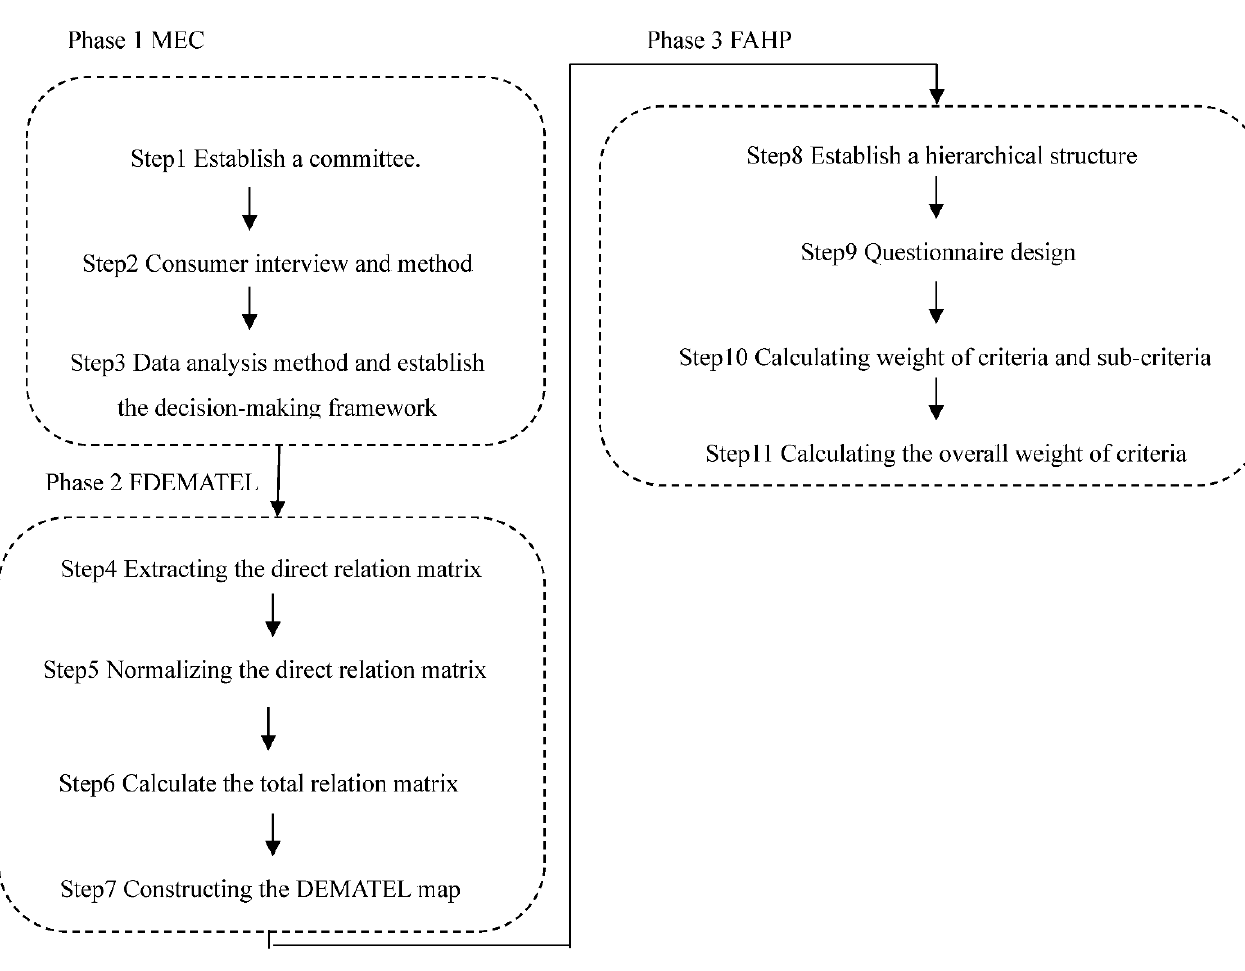
Figure 1. The flowchart of the research methodology.